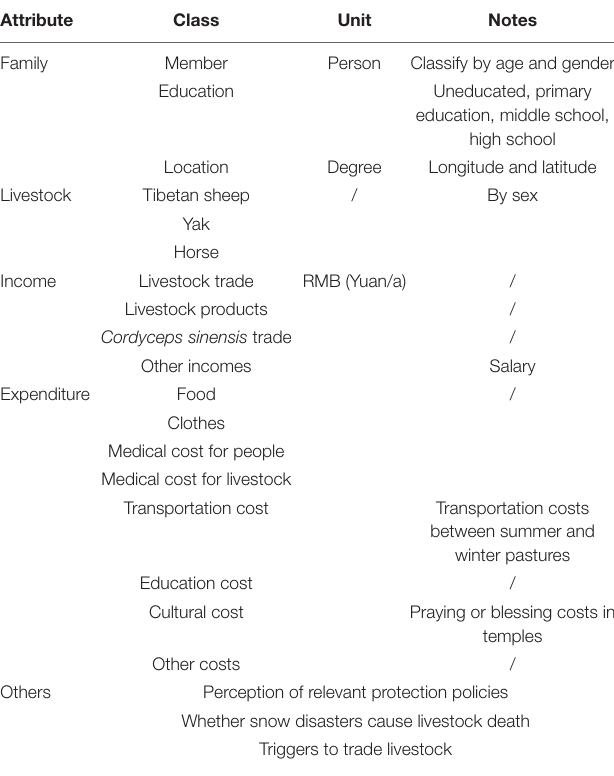
TABLE 1 | Household variables represented in the DECUMA